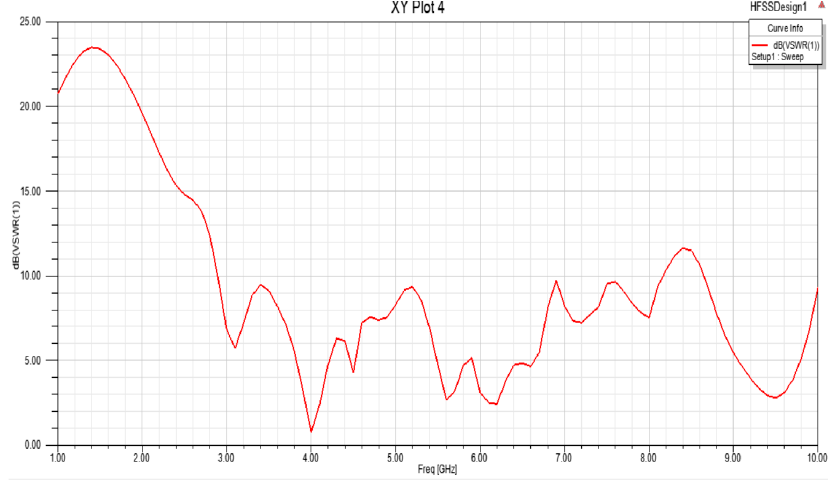
Figure 14. VSWR of multi-stacked DRA.